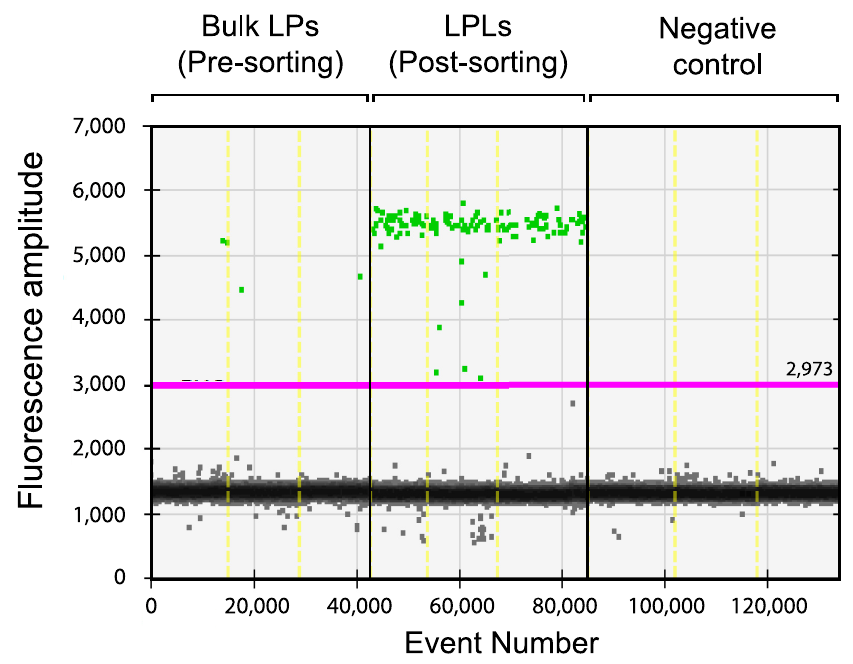
Fig 3. Droplet digital PCR dot plot for GAG amplification. Representative results from LPs (pre-sorting), LPLs (post-sorting)and negativecontrols.